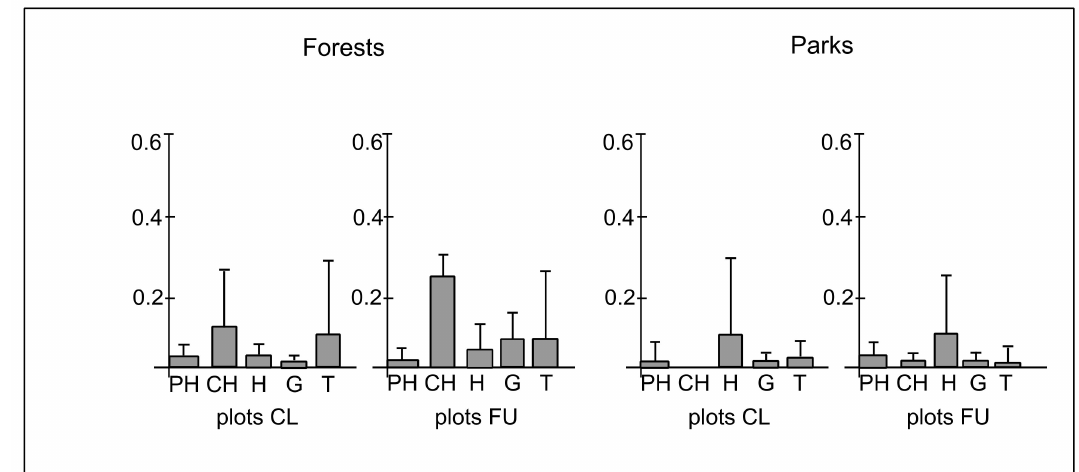
Figure 5. The mean (boxes) and standard deviation (whiskers) values of cover-abundance de- gree of species representing different life forms (PH—phanerophytes, CH—chamaephytes, H— hemicryptophytes, G—geophytes, T—therophytes) per plot in closer (CL) and further (FU) plots located along paths in forests and